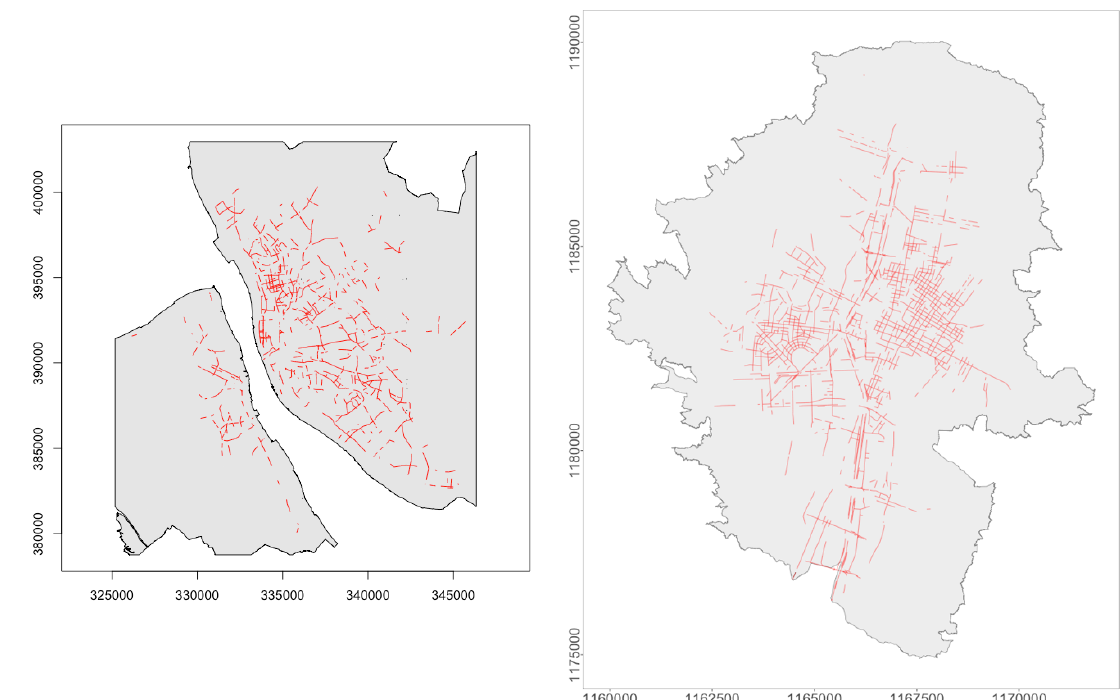
Figure 11. Segments at which NAIN local-scale segments overlap with NAIN global-scale segments for Liverpool (left) and Medellín